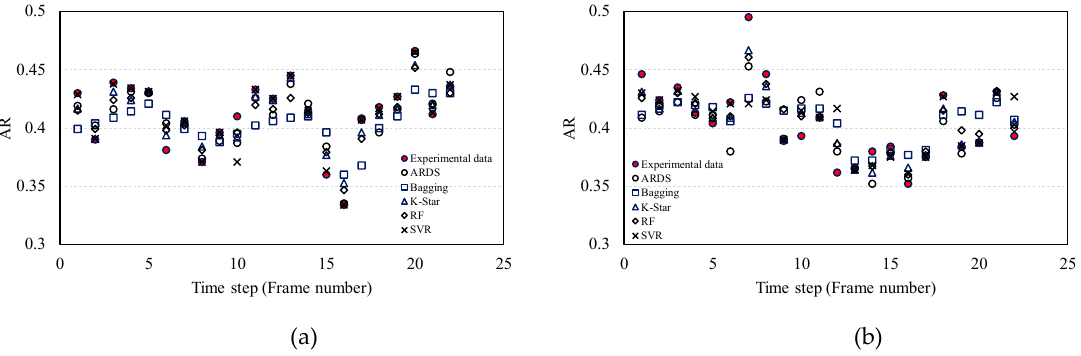
Figure 12. Comparison among aspect ratios by means of time series; ( a ) Model 1—bubble 1; ( b ) Model 2—bubble 12.